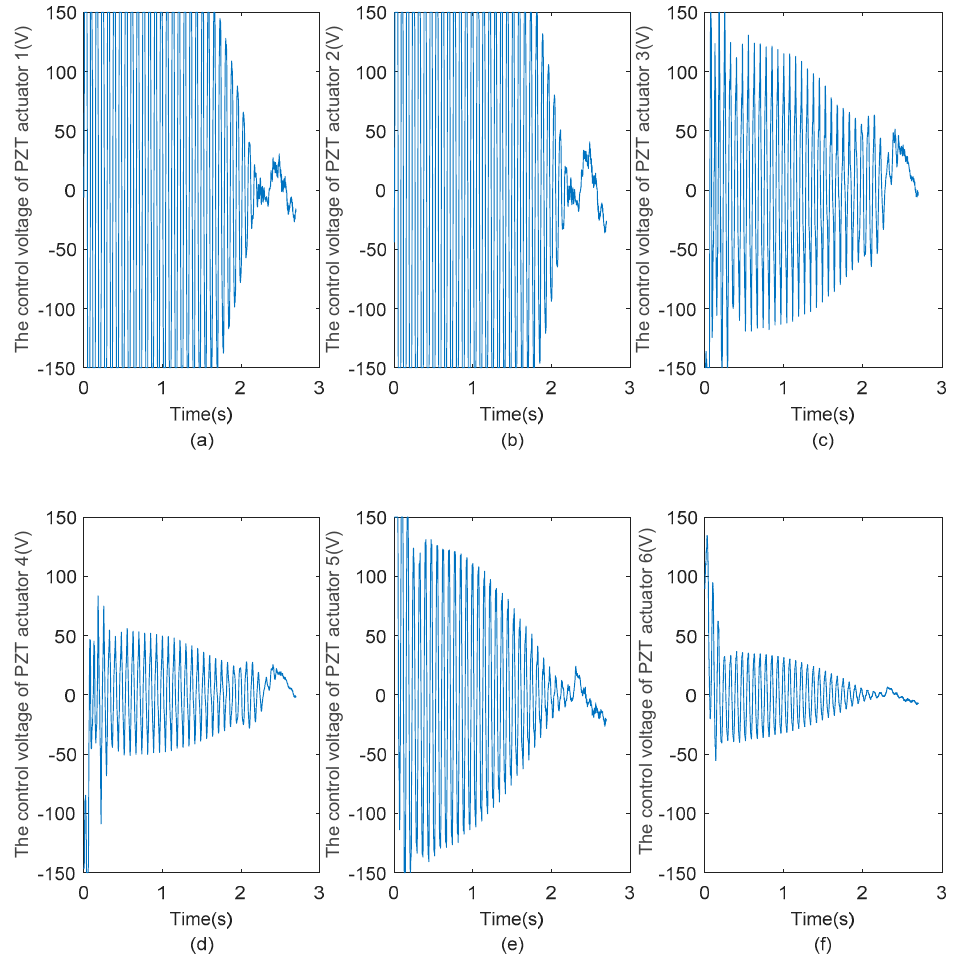
Figure 19. ( a – f ) Control voltages exerted pairs of PZT actuators 1, 2, 3, 4, 5, and 6, respectively.